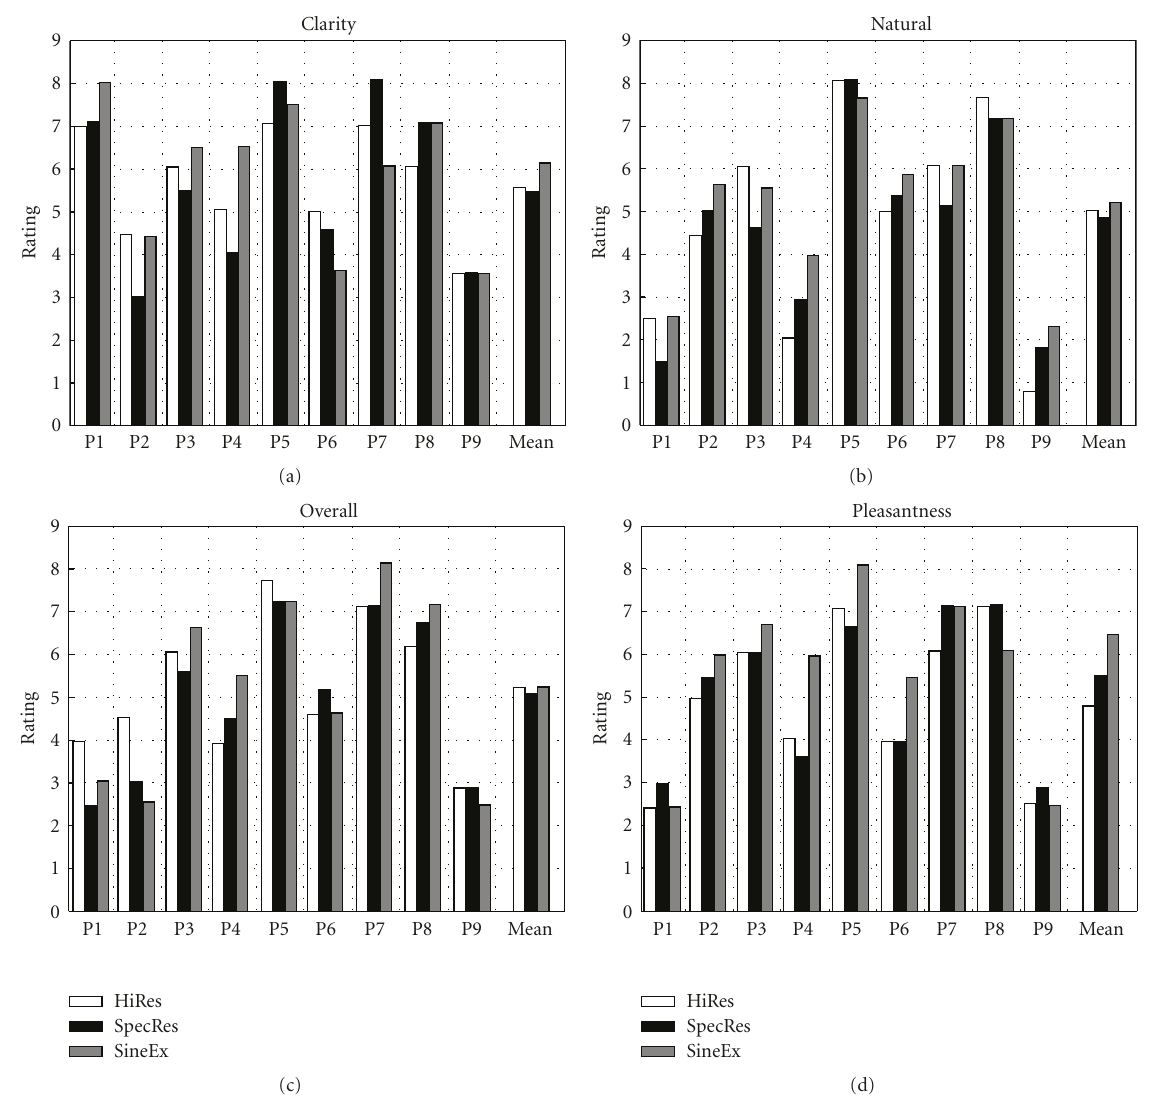
Figure 11: Results of the music quality questionnaire using HiRes, SpecRes, and SineEx. Di ff erent items were rated on a 10-point scale. The cochlear implant subjects were asked to rate di ff erent aspects of music perception. The items are (a) clarity of music, (b) natural music perception, (c) pleasantness hearing music, and (d) overall music